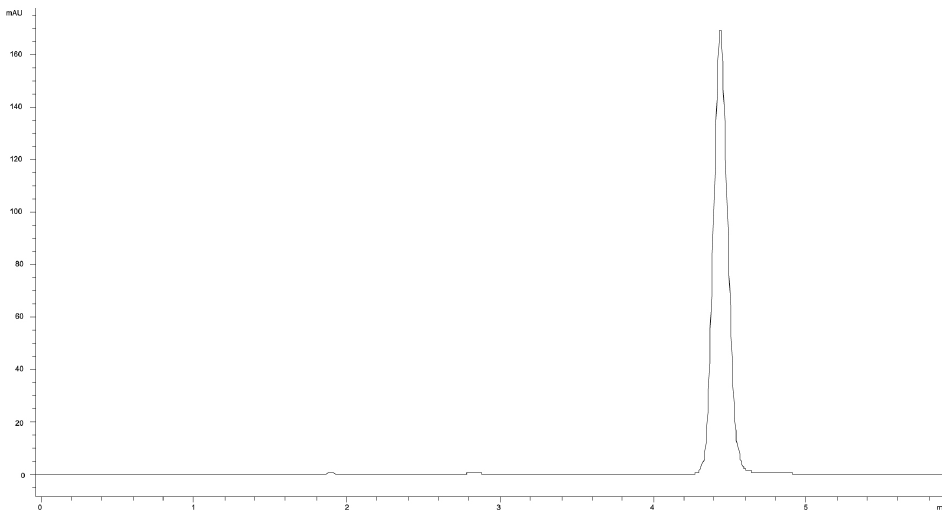
FIGURE 2 - Chromatogram obtained with acetonitrile:water (22:78), using an ACE C18 column (250 × 4.6mm I.D.; 5 µm particle size), at 30 °C, detection at 260 nm. Retention time of fluconazole peak was 4.44 min.